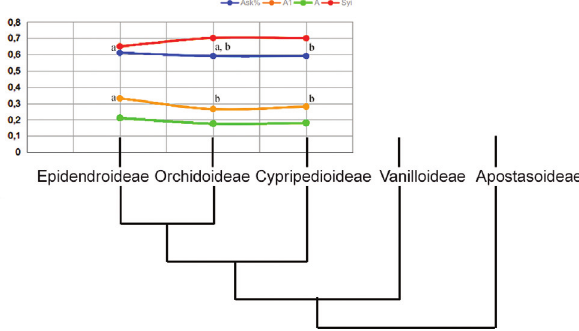
Figure 3 - Intrachromosomal asymmetry values obtained by Ask% (blue), A1 (red), A (green) and Syi (orange) indexes for the Orchidaceae subfamily. The numeric scale at the right side indicates the mean value for the four intrachromosomal indexes. The Syi value was divided by 100. Subfamilies indicated by the same letters are not significantly different (Tukey test, p <